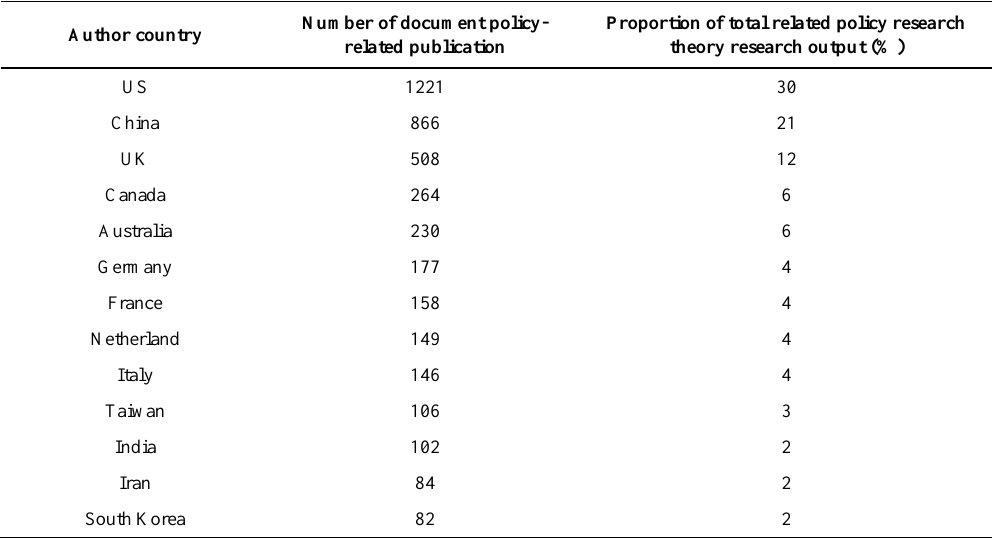
Table 1. Country affiliation of authors publishing the most theory related policy research (selected